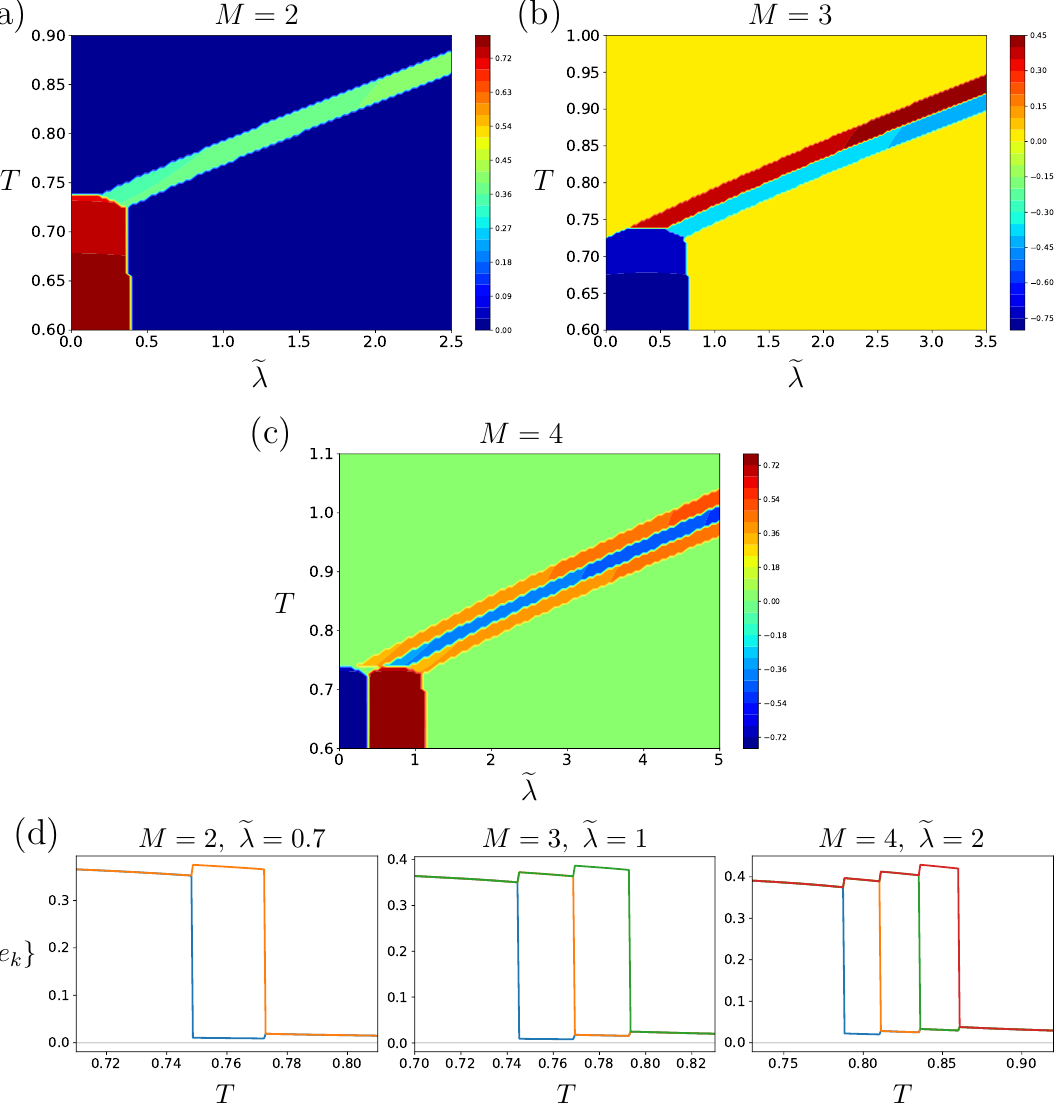
g 2 = 5 . All e g 1 = 1 and g 2 = 5 at µ = 0 . As e e